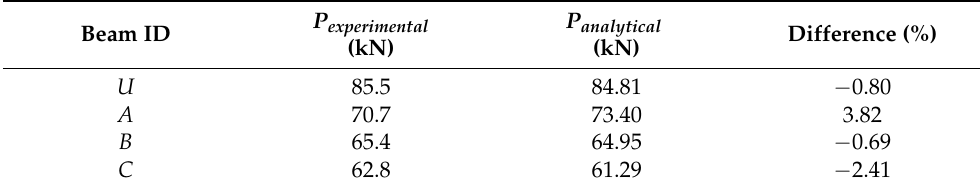
Table 3. Experimental and analytical values of load-carrying capacities of control and corroded RC beams (using actual mass